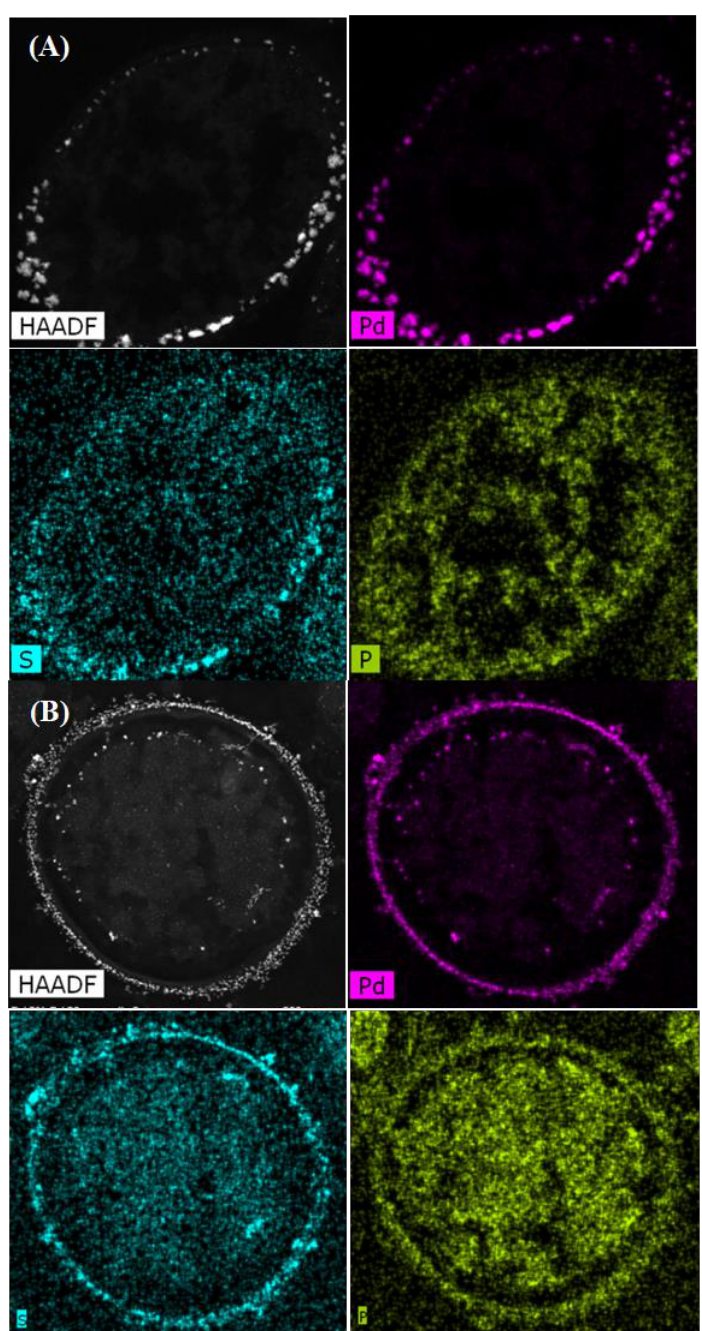
Figure 4. Elemental mapping showing distribution of Pd, P, and S in untreated cells of D. desulfuricans ( A ) and cells treated with MW for 30 sec ( B ). The Manders overlap coe ffi cients were higher than 0.9 for Pd / P and Pd / S in control and MW-treated cells.